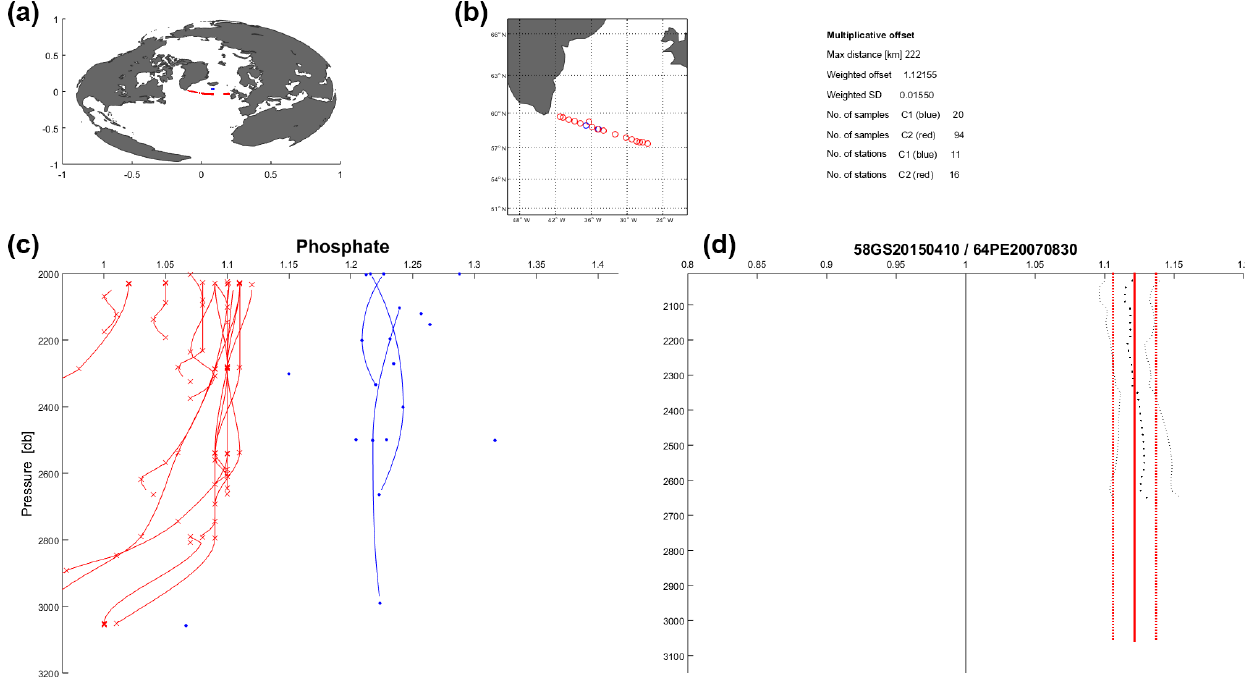
Figure 3. Example crossover figure, for phosphate for cruises 58GS20150410 (blue) and 64PE20070830 (red), as it was generated during the crossover analysis. Panels (a) and (b) show the station positions; panel (c) shows the data below the upper depth limit (in this case 2000dbar as the Irminger Sea is a site of active deep mixing; Fröb et al., 2016) as points and the interpolated profiles as lines. Non-interpolated data either did not meet minimum depth separation requirements (Table 4 in Key et al., 2010) or are the deepest sampling depth. The interpolation do not extrapolate to this. Panel (d) shows the mean difference (as a ratio) profile (black, dots) with its standard deviation, and also the weighted mean offset (straight, red) and weighted standard deviation. Summary statistics are provided in (b)